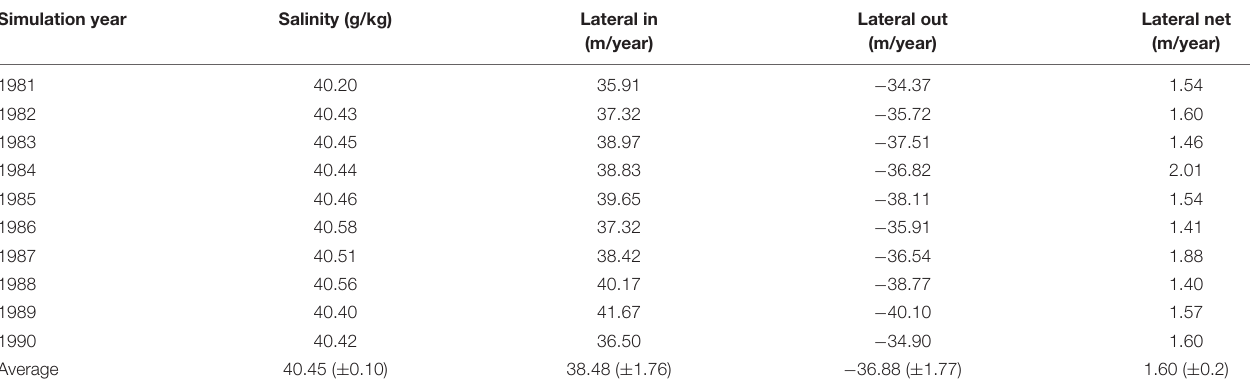
TABLE 2 | Gulf annual mean basin-average salinity and lateral inflow (in), outflow (out), and net exchange fluxes a in Ic1 experiment. Simulation year Salinity (g/kg) Lateral in